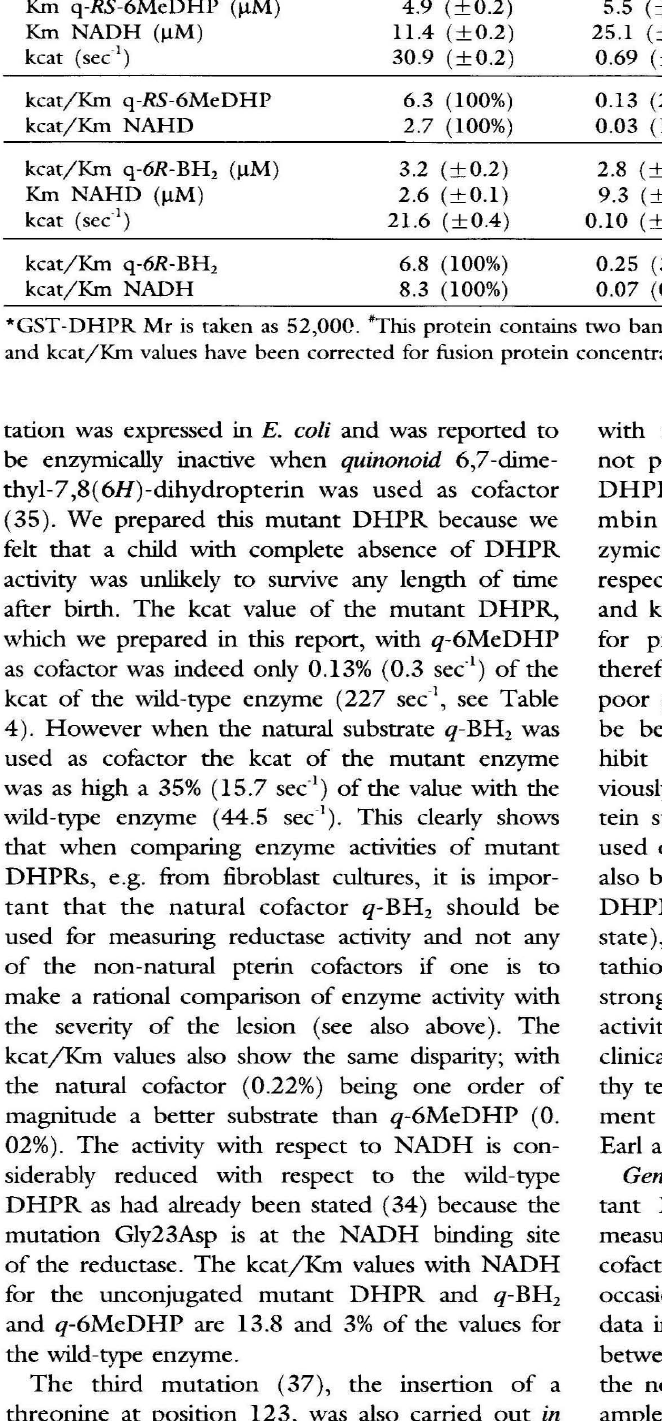
Table 5. Kinetic parameters of mutated GST-DHPRs* in PKU patients. 0.1 M Tris-HCI buffer pH 7.4, at 25°C